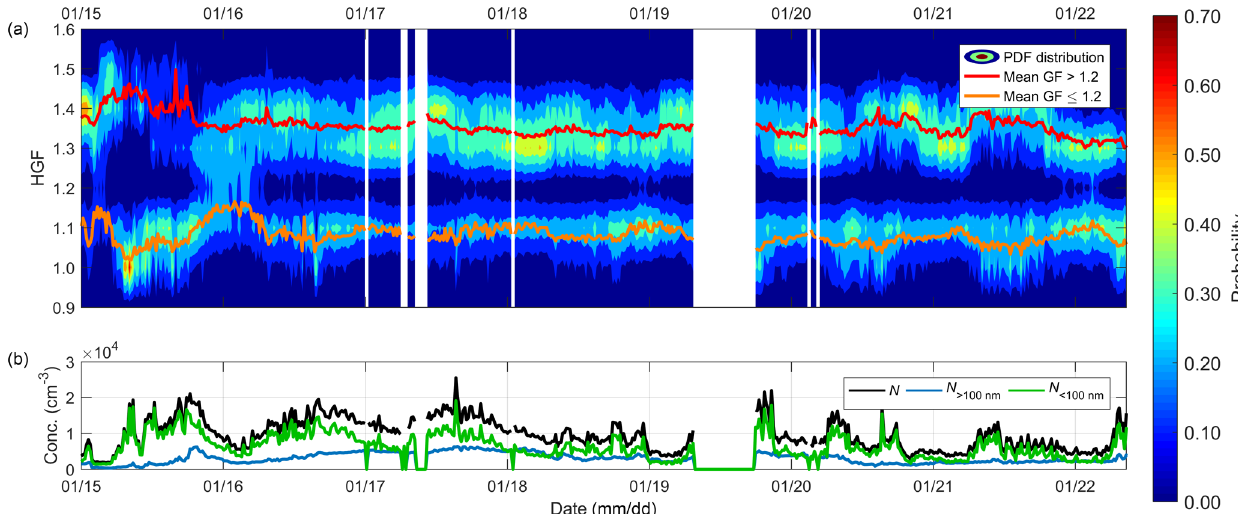
Figure 1. Temporal variability of the hygroscopic diameter growth factor probability density function (HGF-PDF) (a) at a RH = 90% for particles with a dry diameter of 145nm from 15 to 22 January 2015. The orange line displays the mean HGF of the nearly hydrophobic mode (HGF NH ), while the red line shows the mean HGF of the less hygroscopic mode (HGF LH ). Total particle number concentration ( N , black line) and concentrations of N < 100 (green line) and N > 100 (blue line) are also shown in (b)